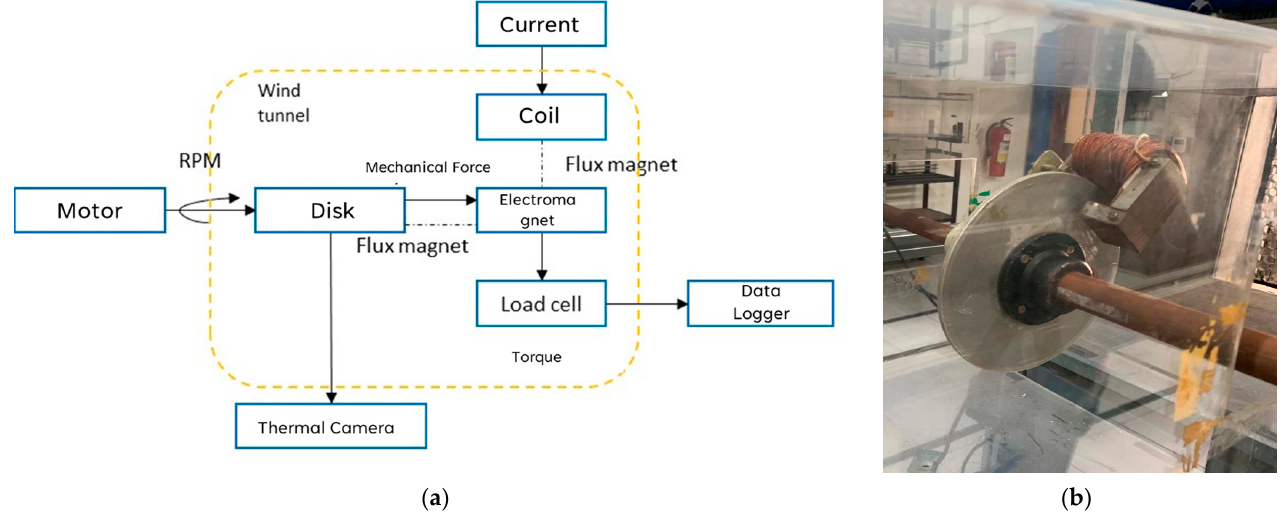
Figure 2. ECB experimental design carried out: ( a ) experimental test scheme, ( b ) test equipment used.